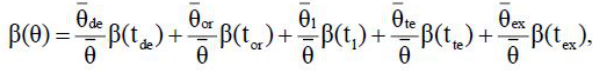
EAI Endorsed Transactions on Energy Web and Information Technology 10 201 7 - 1 2 2017 | Volume 4 | Issue 1 5 | e 5